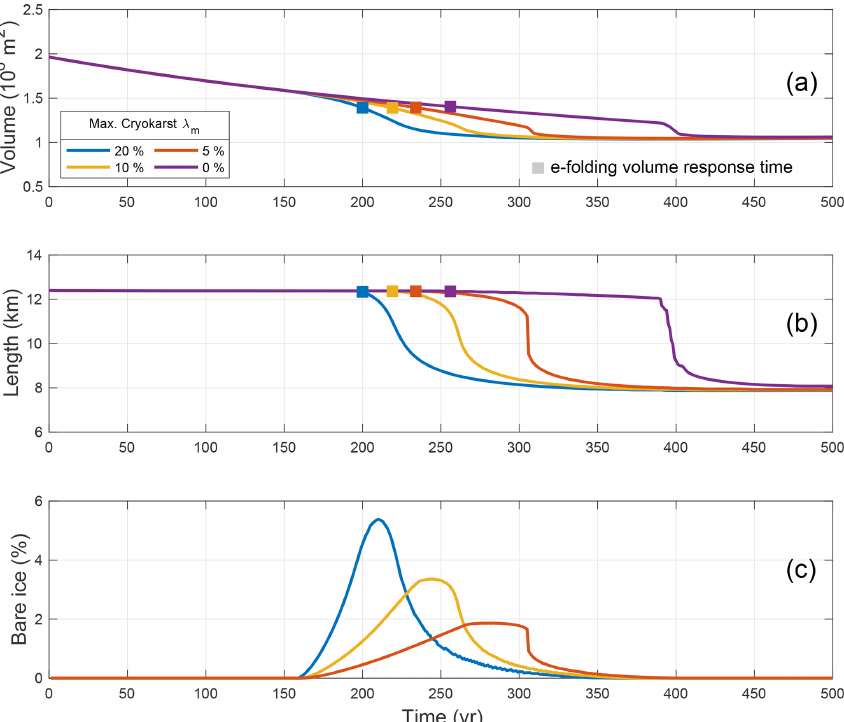
Figure 7. Transient volume response (a) and length response (b) for debris-covered glaciers with terminal cryokarst features retreating from steady state after a 100m step change in ELA. Each colour represents a different value of the maximum cryokarst percentage λ m . In all cases, the debris concentration is c = 0 . 25%, and the driving stress thresholds are τ + panels (a) and (b) represent the e -folding volume response time. The percentage of total debris-covered length that has a bare ice equivalent surface mass balance due to the presence of cryokarst is shown in panel (c)